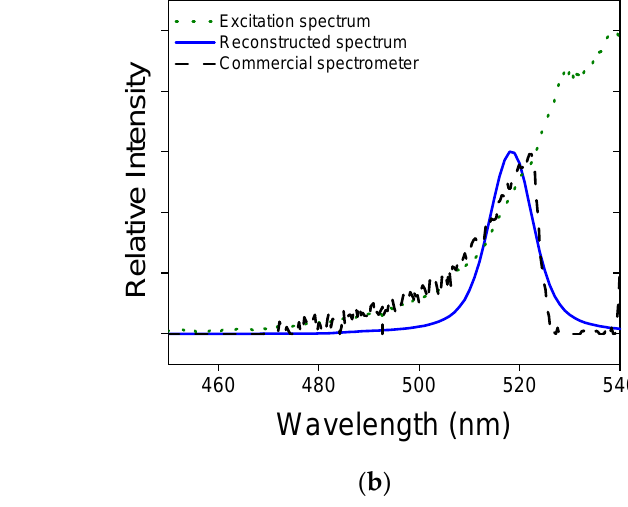
( c ) Figure 3. ( a , b ) The responsivities of the 13 photodetectors measured at a zero bias using a tunable monochromatic light source (adapted from [22]). The optical power at the sample was characterized separately using an integration sphere. The photocurrent was measured using a semiconductor pa- rameter analyzer (Keithley 4200). The legend shows the nanopillar’s diameter in each photodetector. ( c ) Determination of the spectrometer’s operating range using an NNLS algorithm with a series of delta-function spectra between 450 nm and 590 nm. The shaded area from 541 to 590 nm indicates the wavelength range in which the reconstruction has a large error. The result implies an operating range from 450 nm through 540 nm. Next, we demonstrated the feasibility of the monolithically integrated LED light source in the configuration of reflection spectroscopy. We placed a mirror approximately 4 cm from the sample, as shown in Figure 4a. We then inserted a notch filter (Thorlabs